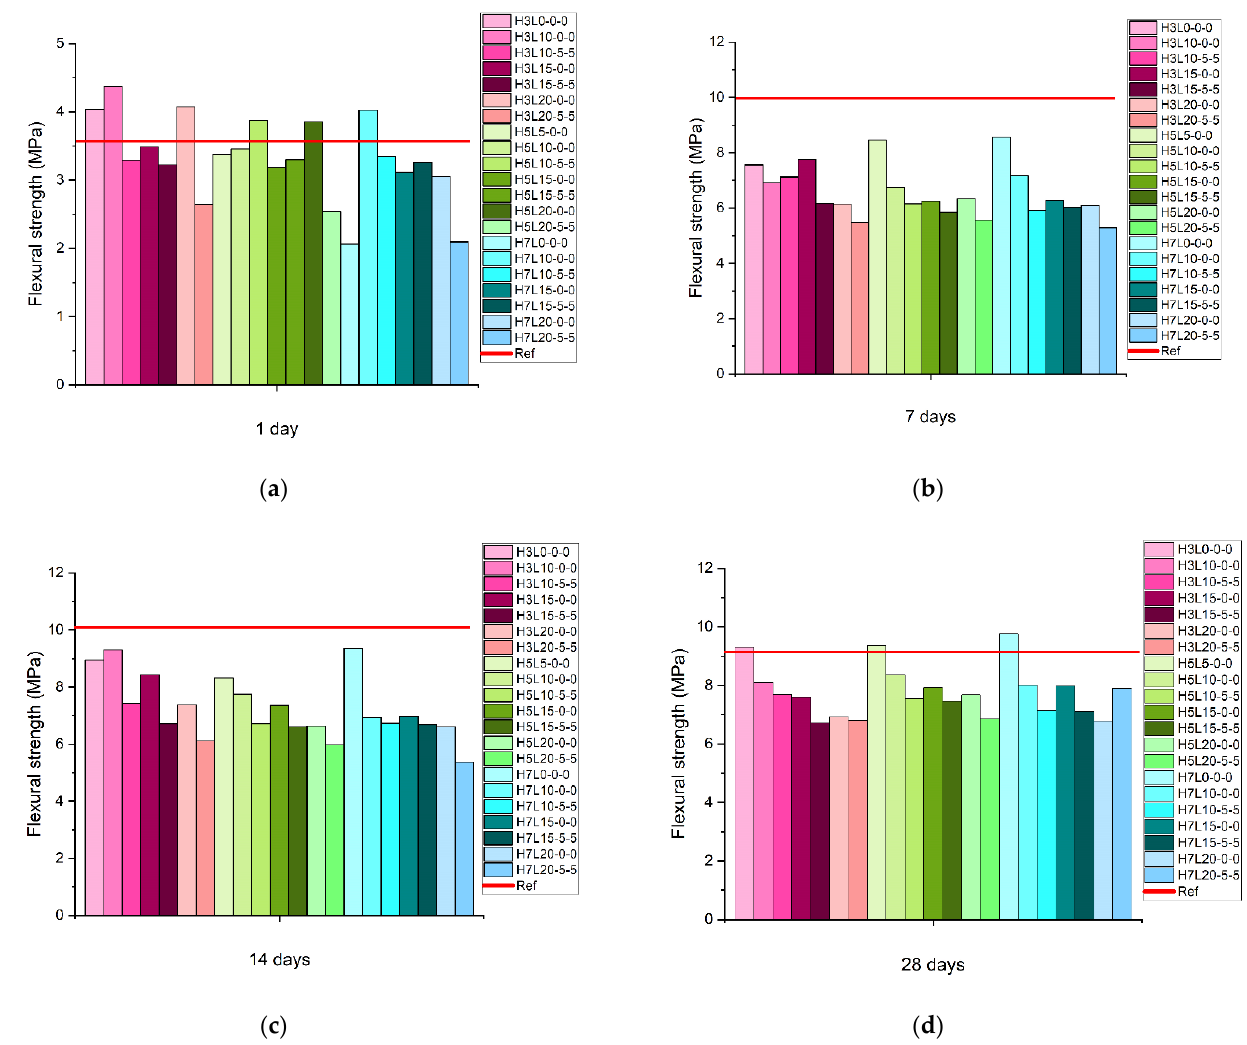
Figure 2. Flexural strength of mortars made with limestone and three contents of coarse silica fume (3%, 5%, and 7%) at: ( a ) 1 day, ( b ) 7 days, ( c ) 14 days, and ( d ) 28 days.